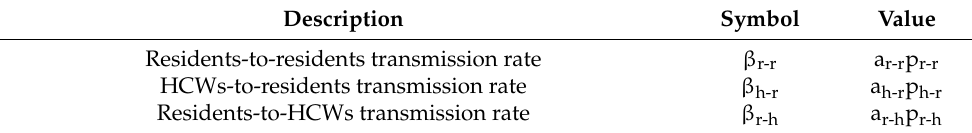
Table 3. The three transmission rates defined in the computational model.